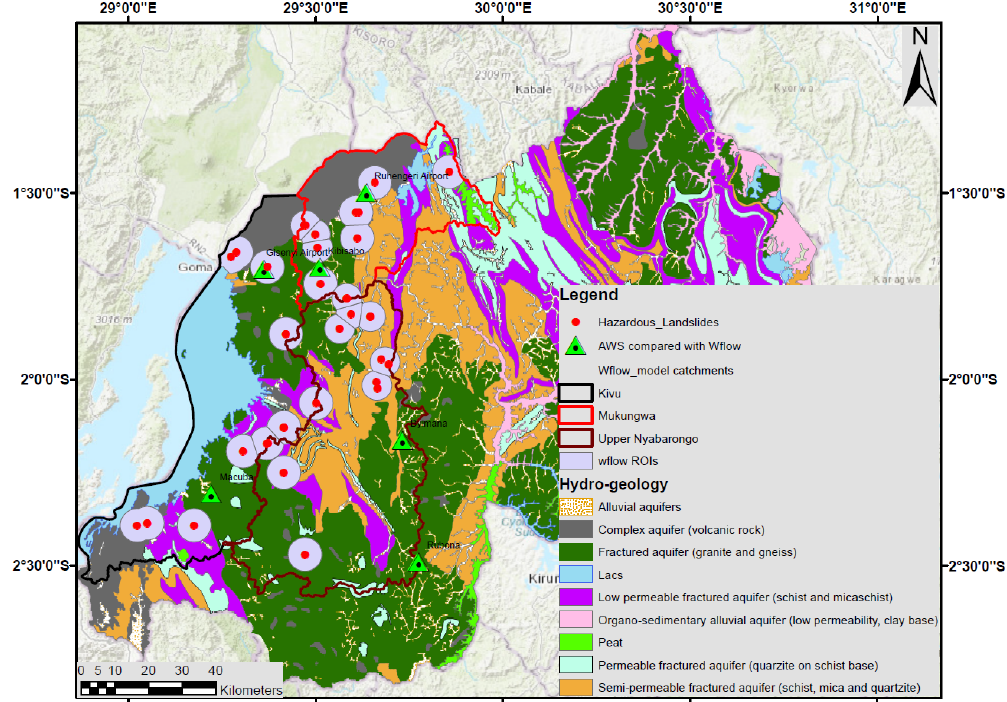
Figure 3. Wflow model catchments (Kivu, upper Nyabarongo and Mukungwa) and hydrogeology, landslides in red dots and 5km buffers indicating the ROIs for areal soil moisture acquisition from the Wflow model, and AWSs with soil moisture sensors for comparative perfor- mance evaluation of the Wflow-modelled soil moisture. Table 1. Pre-selected precipitation products and short